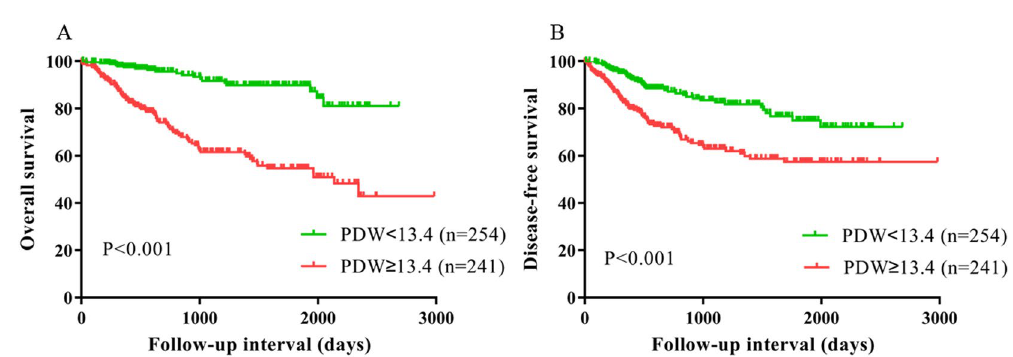
Figure 3. Kaplan–Meier curves for OS ( A ) and DFS ( B ) which was stratified according to PDW value (PDW < 13.4 vs. PDW ≥ 13.4) for ESCC patients after surgery. The difference was evaluated by log-rank tests.